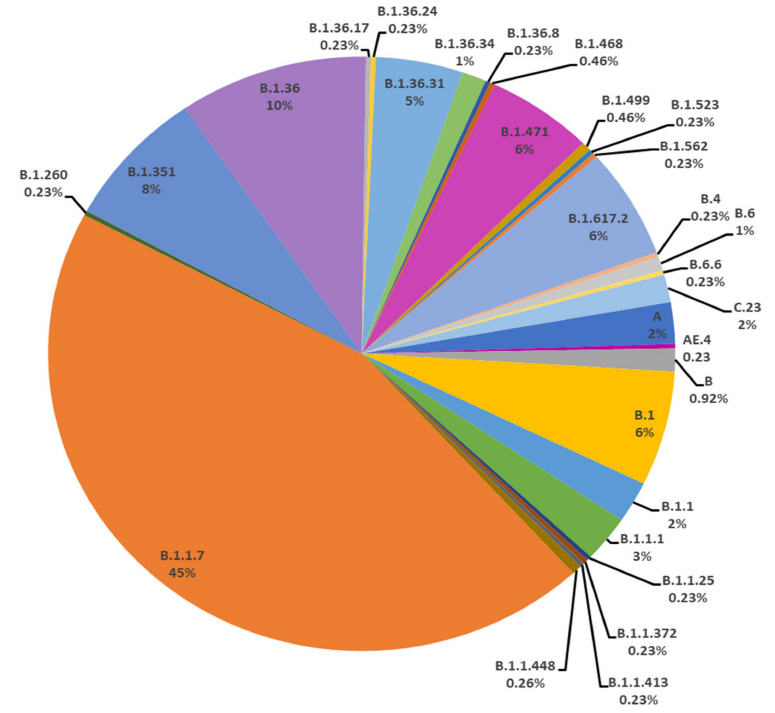
Figure 4. All the lineages observed from Pakistan sequences downloaded on 10 July 2021.